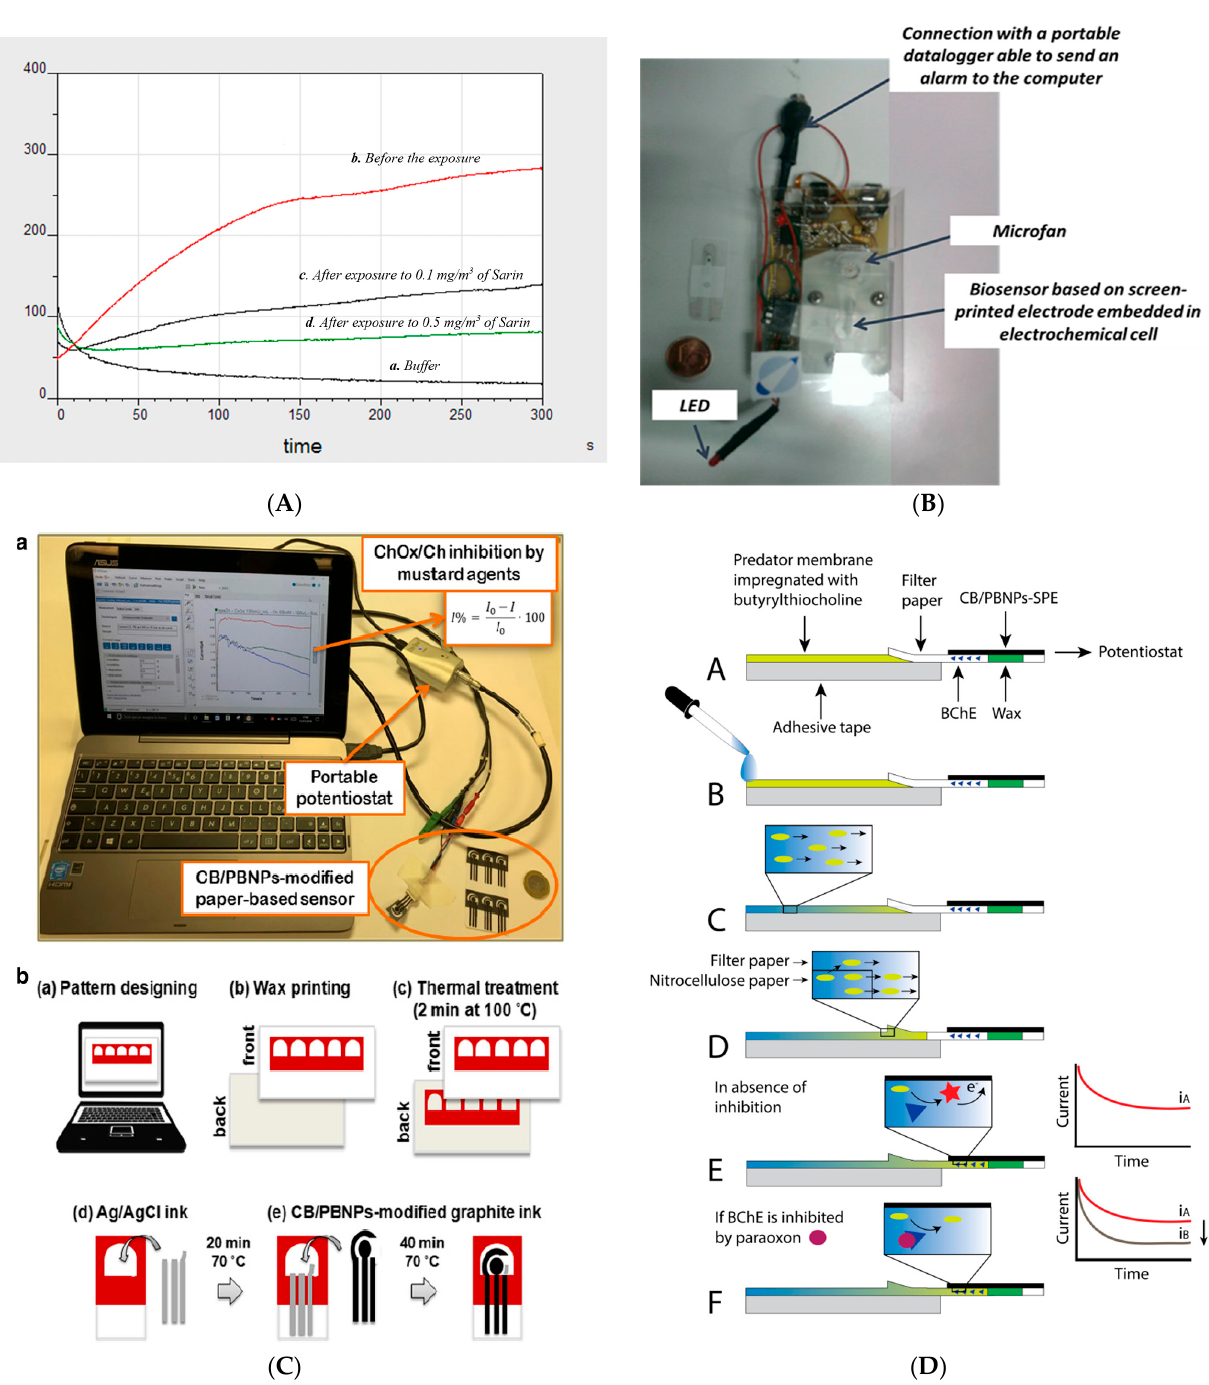
Figure 3. ( A ) Amperograms using the screen-printed electrodes modified with Prussian blue and butyrylcholinesterase before and after the exposure to Sarin gas [27]. ( B ) Screen-printed based butyrylcholinesterase biosensor integrated into a lab on a chip [28]. ( C ) Paper-based screen-printed electrodes as a platform to detect mustard agents using choline oxidase as a biocomponent. (a–e) procedural steps for the realisation of wax-printed office paper serigraphic printing of conductive inks [33]. ( D ) Paper-based screen-printed electrode loaded with butyrylcholinesterase to detect paraoxon as a nerve agent simulant using the following steps (A–F) [34].